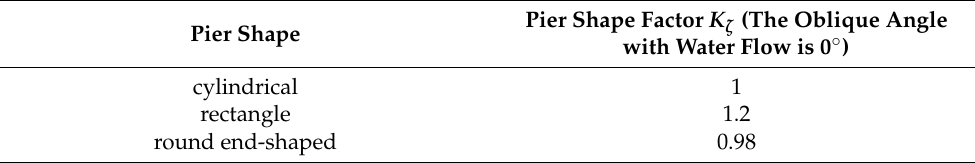
Table 2. The pier shape factors corresponding to different pier